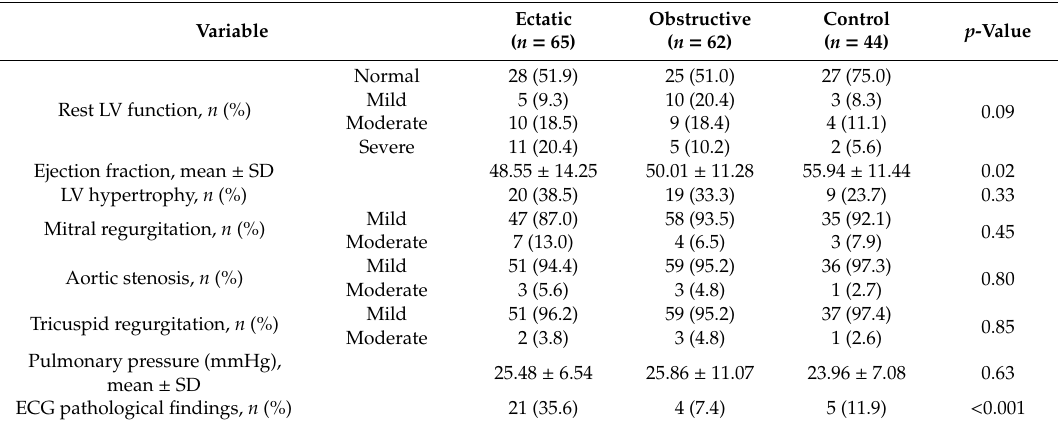
Table 3. Echocardiography and ECG characteristics.